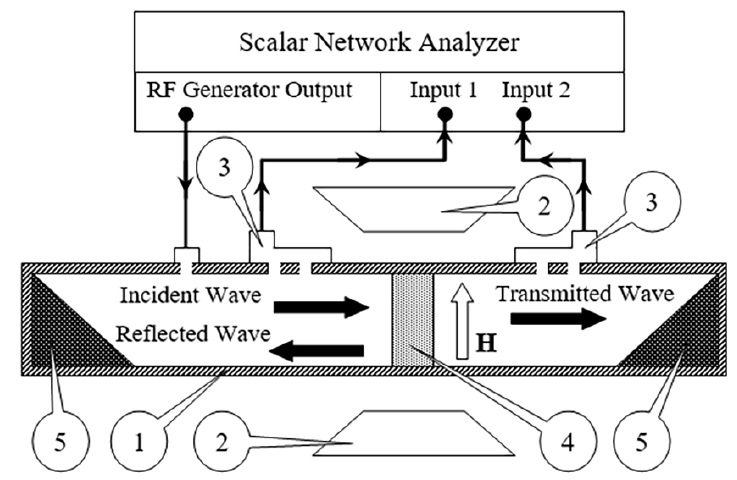
Figure 3. The scheme of microwave measurements: 1—the waveguide; 2—the electromagnet; 3—the directional couplers; 4—the sample; 5—the microwave absorber.